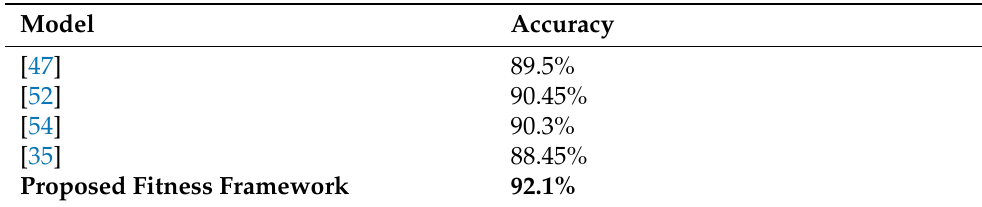
Table 13. Comparative analysis of the proposed fitness framework with existing